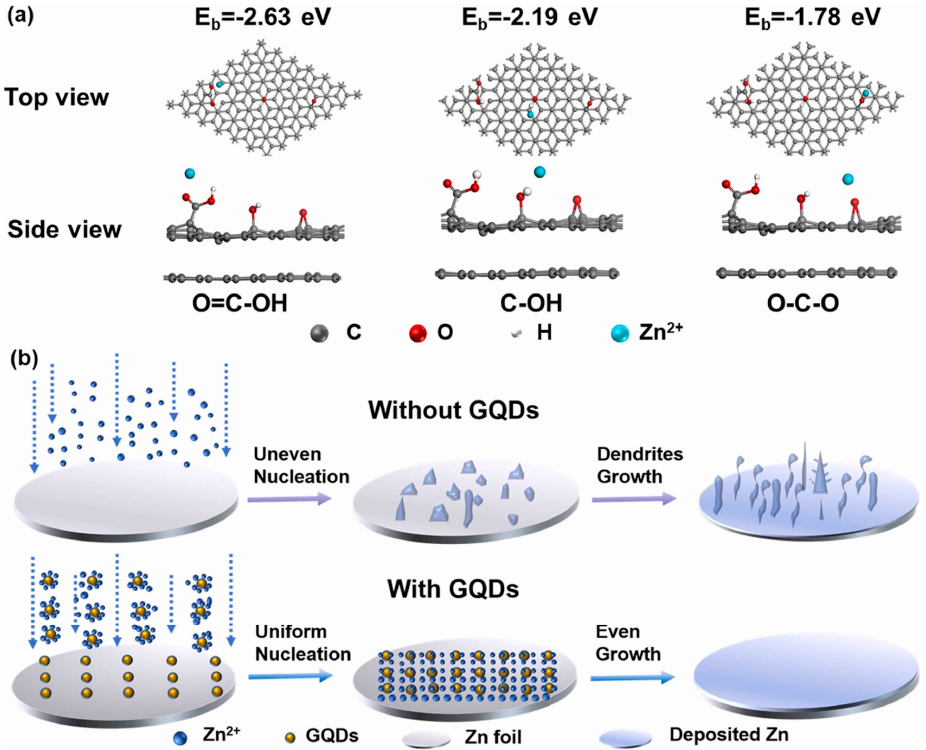
Figure 17. ( a ) Calculation models of Zn ion absorbed on different oxygen-function groups and corresponding binding energy. ( b ) Schematic depiction of the effect toward suppressing dendrites growth. Reproduced with permissions from Ref. [110]. Copyright © 2022 Elsevier Ltd.